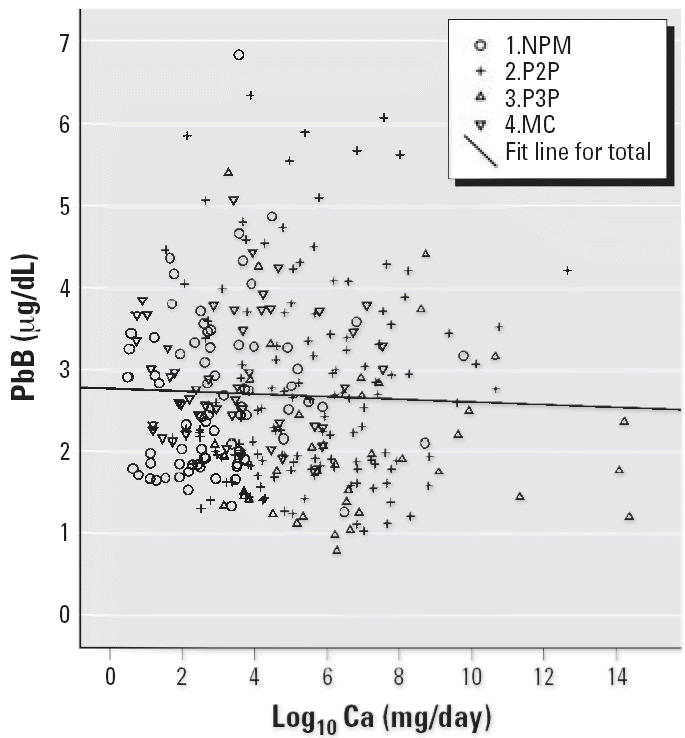
Scatter plot of PbB versus Ca daily intake (log10).